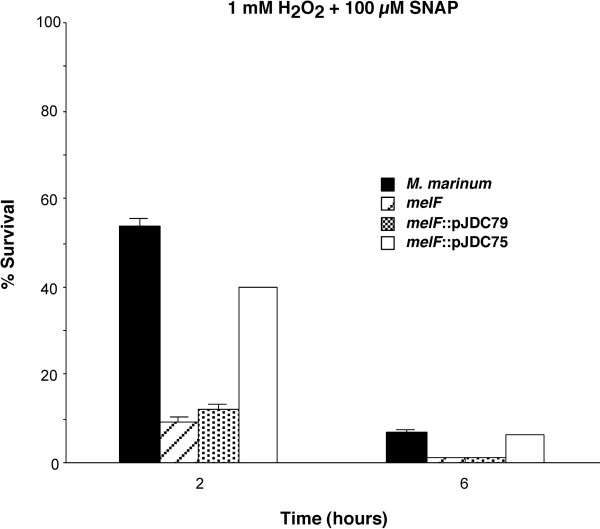
Susceptibility to reactive nitrogen and oxygen species together. Susceptibility of M. marinum wild type as compared to the mel2 mutant that carries an insertion in melF (melF), the mutant carrying a plasmid expressing melF alone (melF::pJDC79) and an integrated single copy plasmid expressing the entire mel2 locus (melF::pJDC75) to H2O2 plus S-nitroso-N-acetyl penicillamine (SNAP). The % survival = (CFU Tx/CFU initial) × 100. Data are the means and standard deviations of assays done in triplicate, representative of three experiments.